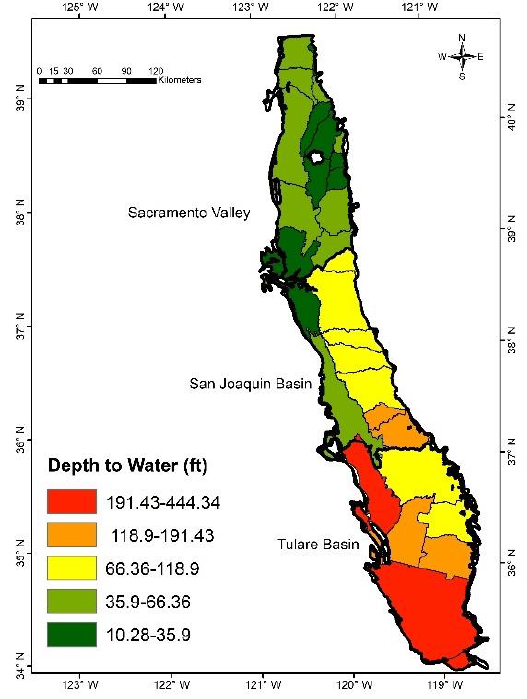
Figure 4. Distribution of depth to water in Central Valley. ISPRS Int. J. Geo-Inf. 2018 , 7 , x FOR PEER REVIEW